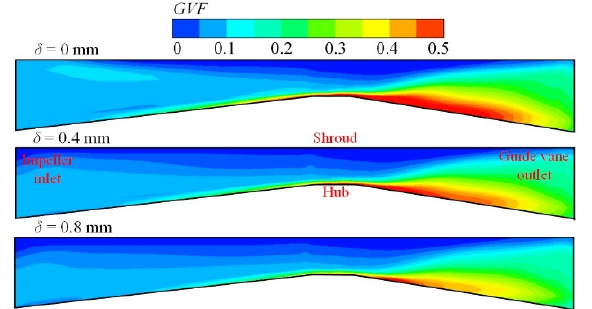
Figure 10. Distribution of gas volume fraction on the meridional plane.